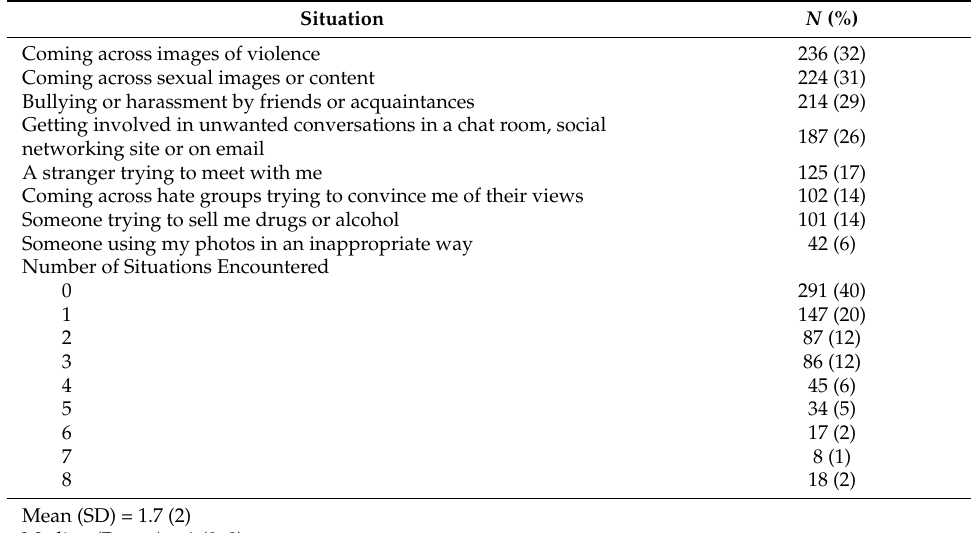
Table 2. Risky Online